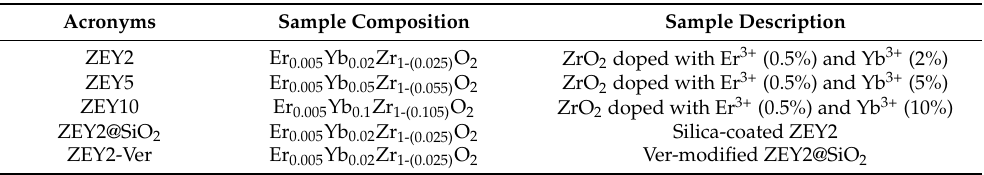
Table 1. Acronyms, composition, and description of the samples prepared and characterized in the present article.